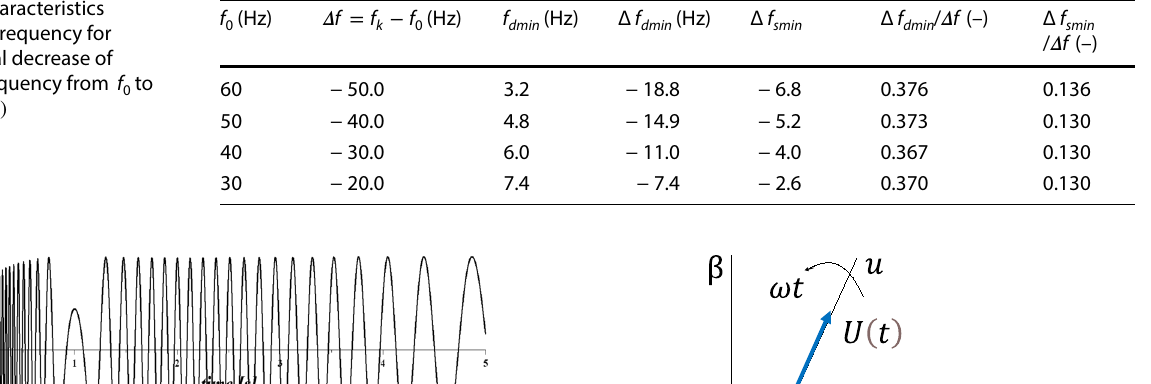
Table 3 Characteristics of current frequency for exponential decrease of voltage frequency from f 0 to